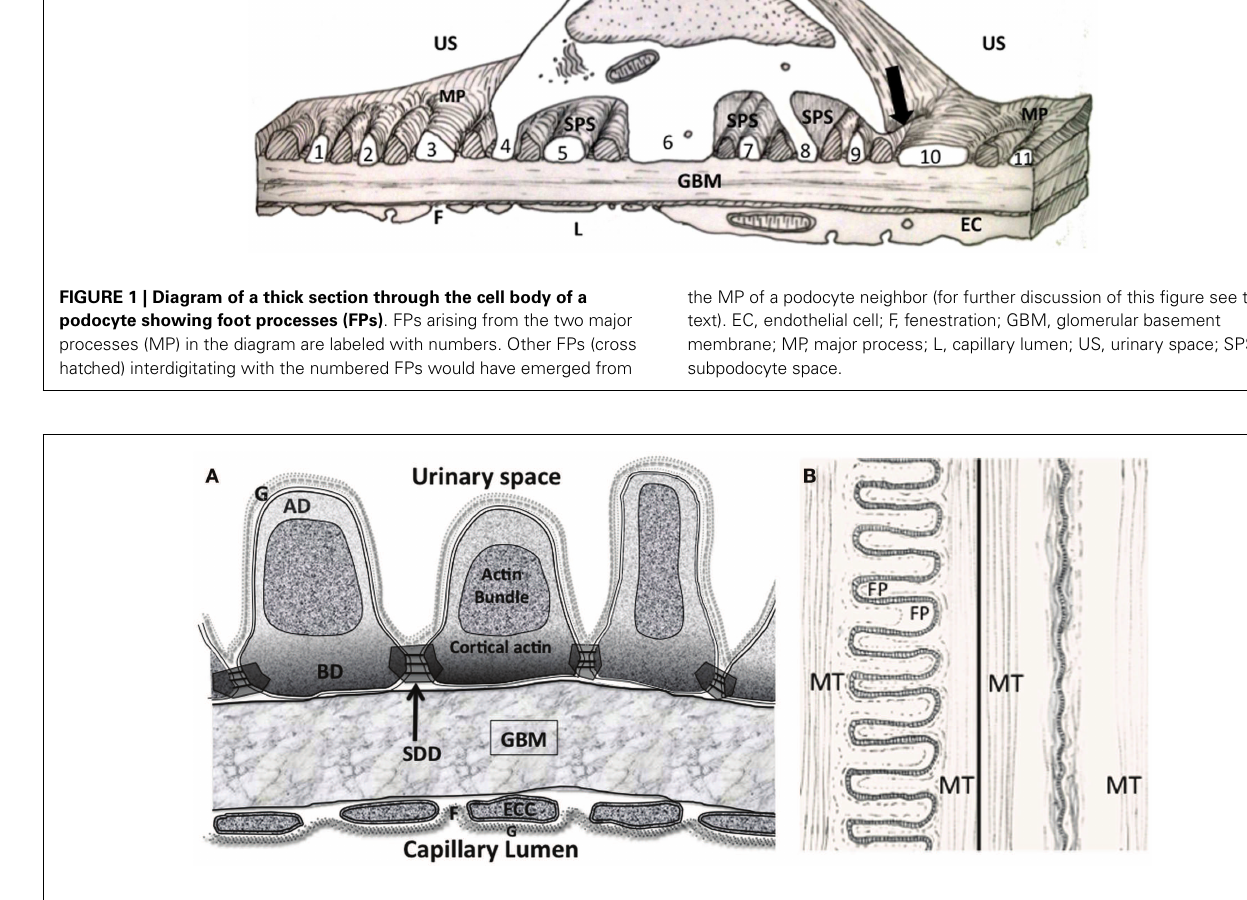
FIGURE 2 | (A) The glomerular filtration barrier (GFB) with the disposition of membrane associated domains in foot processes (FPs). Diagram shows three FPs with apical domain (AD), basal domain (BD), and slit diaphragm domains (SDD) outlined.The apical actin bundles are shown, other actin networks cortical actin (sub-plasmalemmal actin) surrounding the actin bundle are attached to the various membrane domains.The cortical actin meshwork in